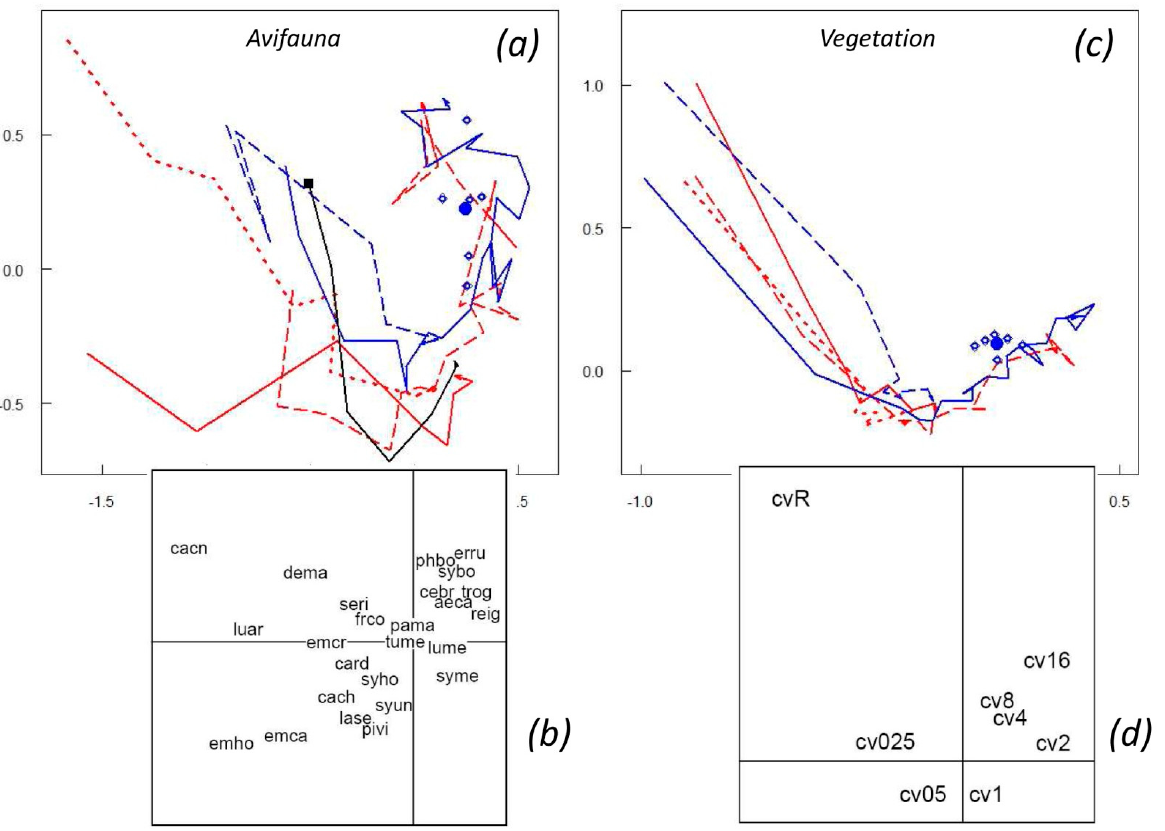
Figure 3. ( a ) Trajectories of the yearly surveys in the first two-dimensional space of the correspondence analysis of the bird matrix. ( b ) Ordination of the bird species in the same space (some species close to the origin have been omitted for the sake of clarity). ( c ) Trajectories of the surveys of burned areas in the first two-dimensional space of the correspondence analysis of the vegetation cover matrix. ( d ) Ordination of the seven vegetation layers plus the rock cover in the same space. Graphic conventions: see Figure 2; in black ( a ): trajectory of the 16-ha quadrat. Species abbreviation: see Table A1.